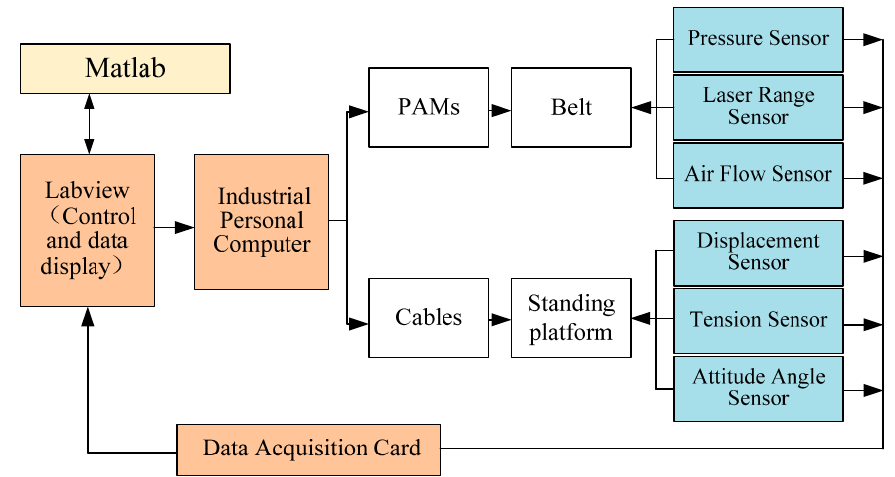
Figure 3. Control and measurement diagram of the HWRR.